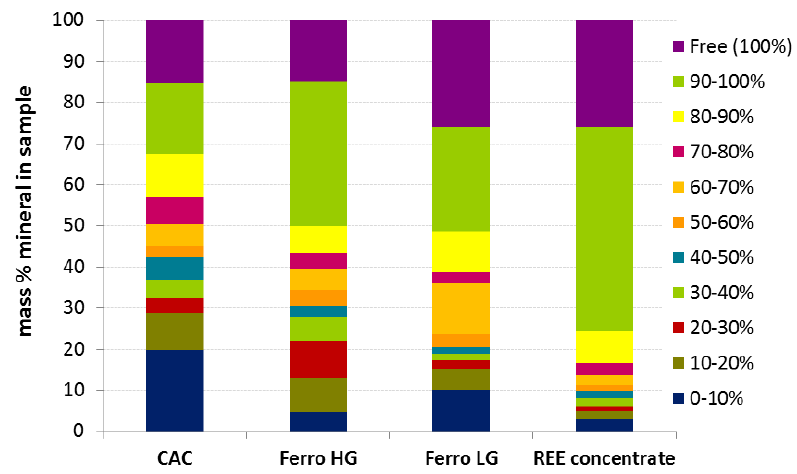
Figure 6. The degree of liberation of REE-bearing minerals in Montviel lithologies and REE concentrate.